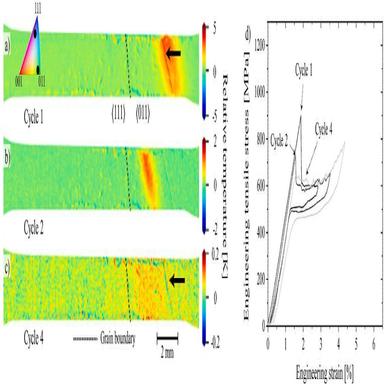
Relative temperature distribution of the oligocrystalline tensile specimen. Thermogram at the time of the maximum temperature increase for the (a) first, (b) second, and (c) fourth deformation cycle. (d) Engineering tensile stress vs. engineering strain hysteresis loops of the first, second, and fourth load cycle. Different scales of relative temperatures in (a), (b) and (c) are applied.